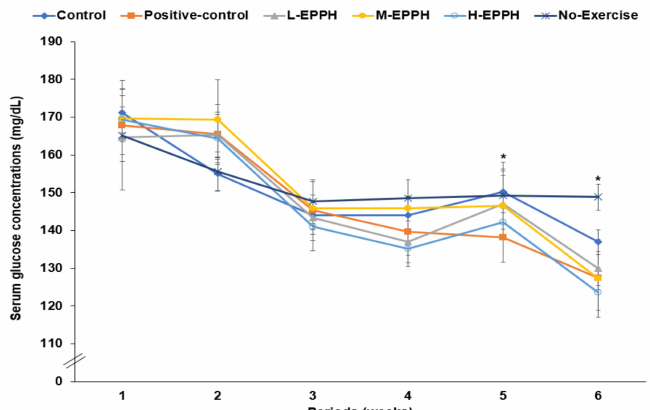
Figure 2. Fasting serum glucose concentrations before exercise-induced fatigue during the experimental periods. Dots and error bars in each period represent means ± standard deviation (SD; n = 10). The rats with exercise-induced fatigue had oral administration of distilled water for the control group, porcine placenta enzyme hydrolysates (EPPH) dissolved in distilled water for experimental groups, and glutathione (100 mg/kg body weight) for the positive-control group. EPPH (0.08, 0.16, and 0.32 mL/kg body weight) was orally provided with a feeding needle for the L-EPPH, M-EPPH, and H-EPPH groups, respectively, for 6 weeks. The rats were designated as the no-exercise group without exercise-induced fatigue and oral administration of distilled water. * Significantly different among groups in one-way ANOVA at p <